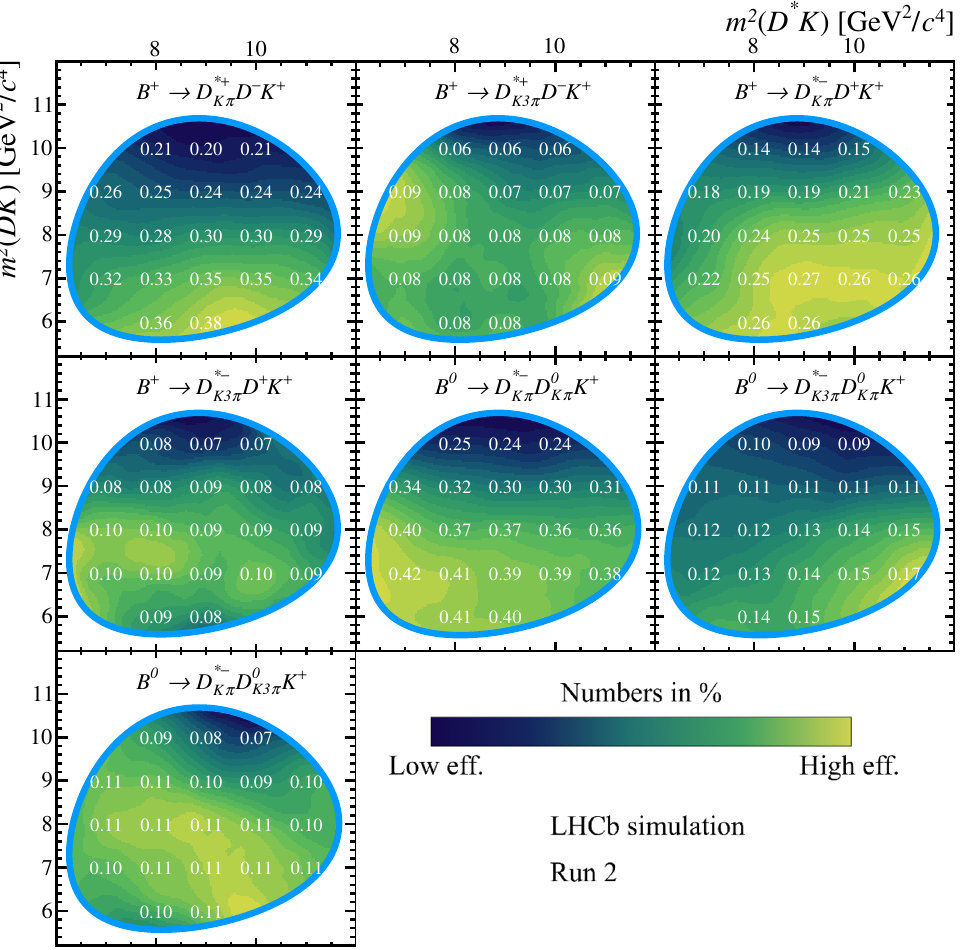
Figure 4 . Selection and reconstruction efficiency, ε sel , as a function of position in the two-body squared invariant-mass plane for the seven B → D ∗ DK modes, obtained using Run 2 simulated samples. A KDE smoothing has been applied. The blue lines indicate the kinematic boundaries and the numbers indicate the values of the efficiency at several points in the phase